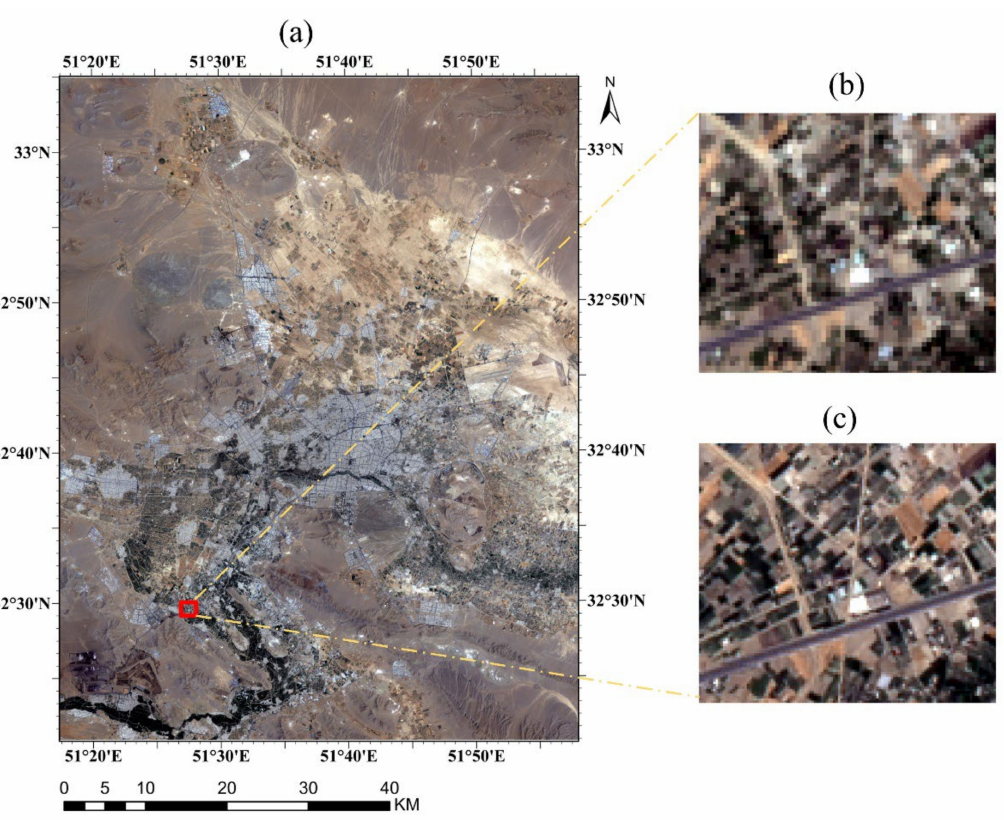
Figure 3. Effect of the pan-sharpening on the 2019 image: ( a ) whole area; ( b ) selected area before pan- sharpening; ( c ) selected area after pan-sharpening. (Red rectangle shows sample area for comparison).